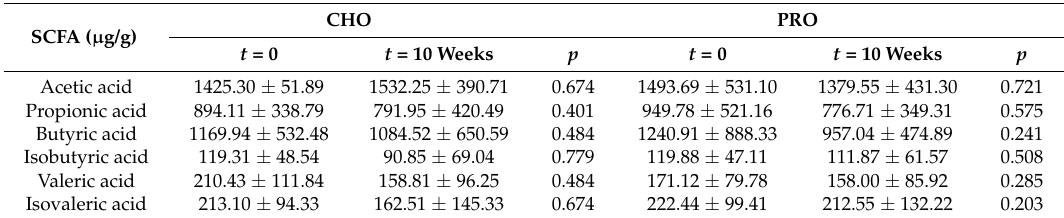
Table 6. Fecal short-chain fatty